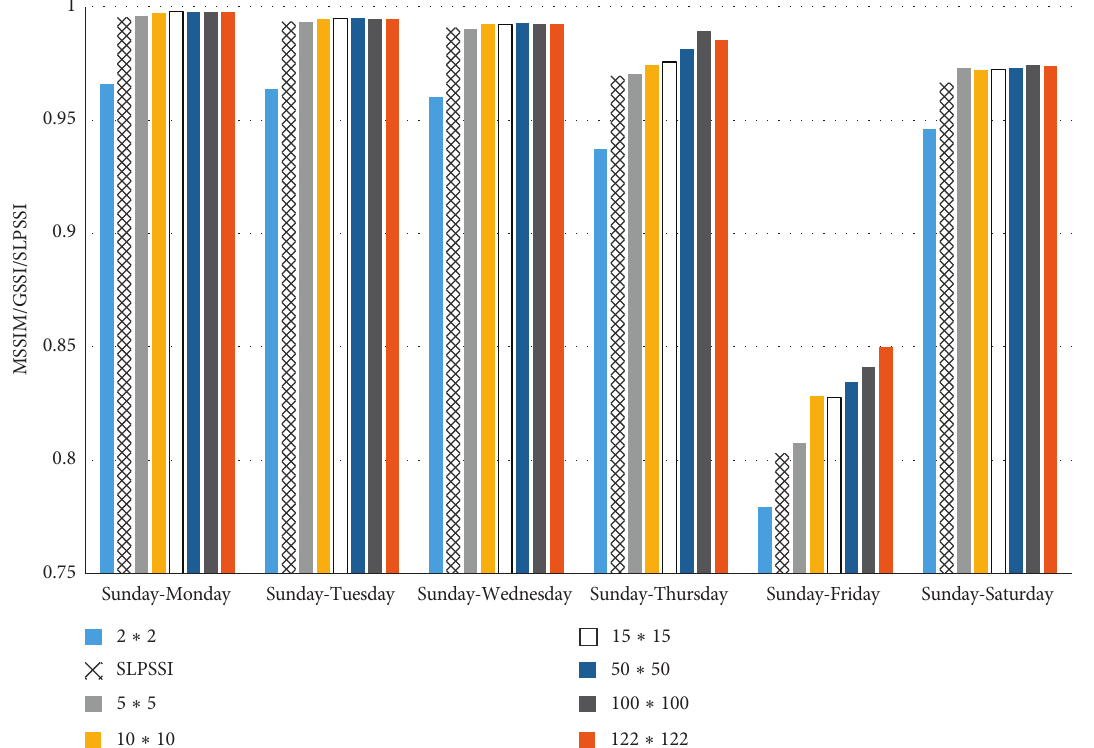
Figure 11: The SLPSSI/GSSI/MSSIM values according to the size of the selected local